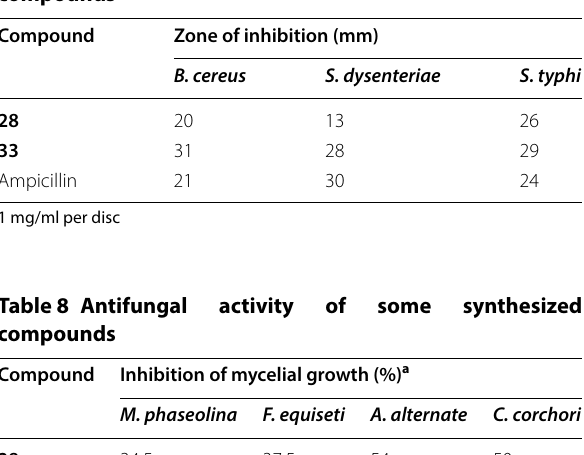
Table 7 Antibacterial activity of some synthesized